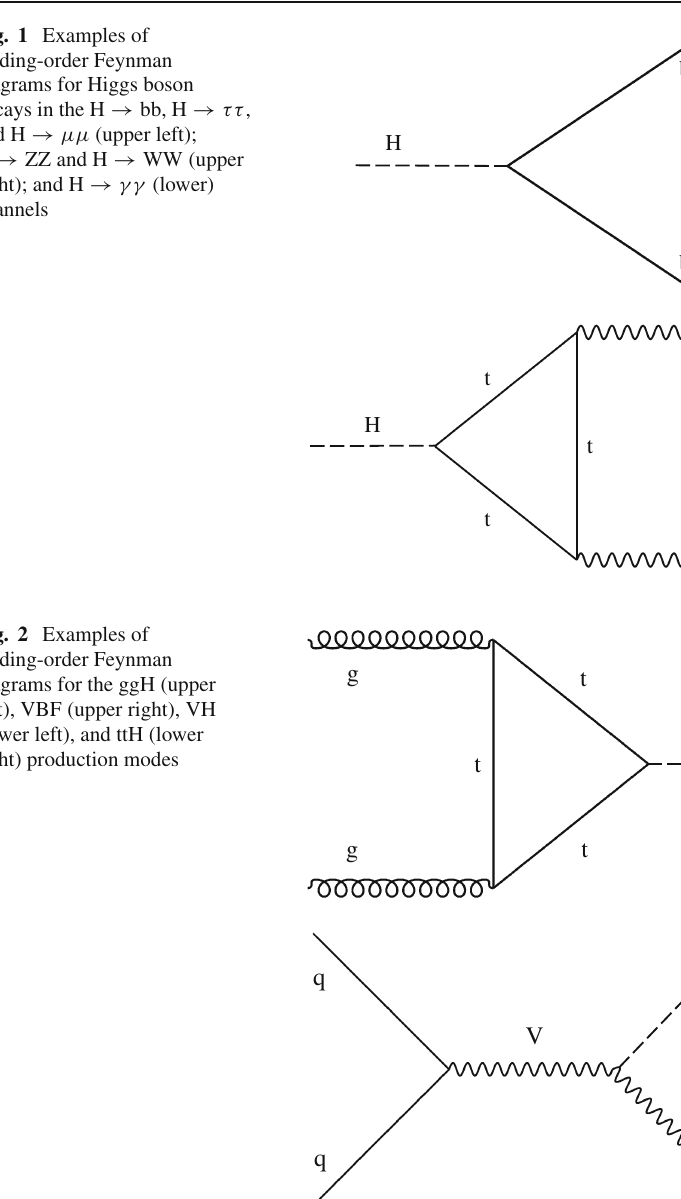
Fig. 2 Examples of leading-order Feynman diagrams for the ggH (upper left), VBF (upper right), VH (lower left), and ttH (lower right) production